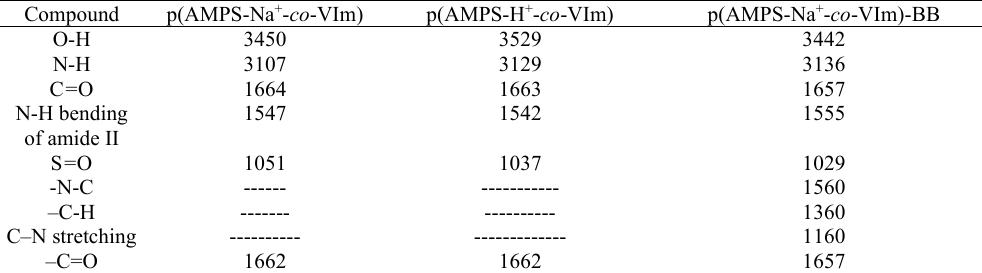
Table 1 Specific bands in FT-IR spectra of hydrogels Table 1. Specific bands in FT-IR spectra of